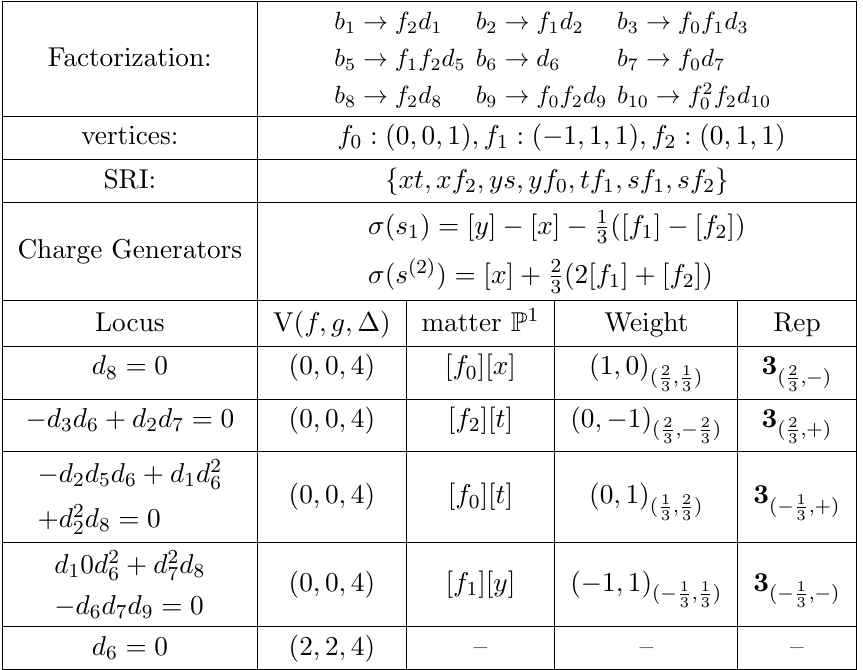
Table 16 . Summary of SU(3) top 2.